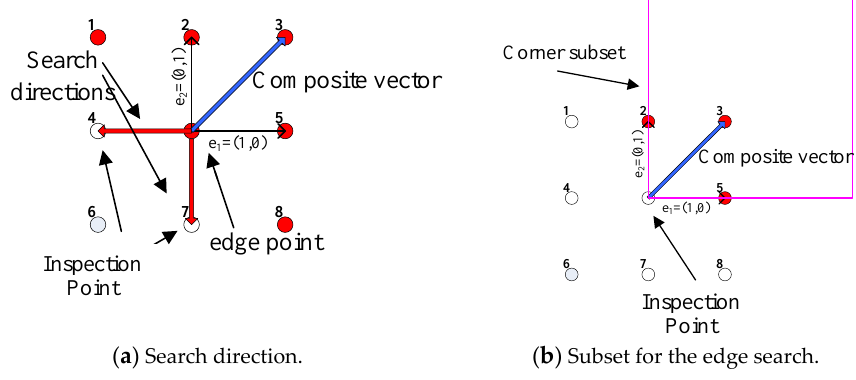
Figure 12. Corner subset for a titling edge search.